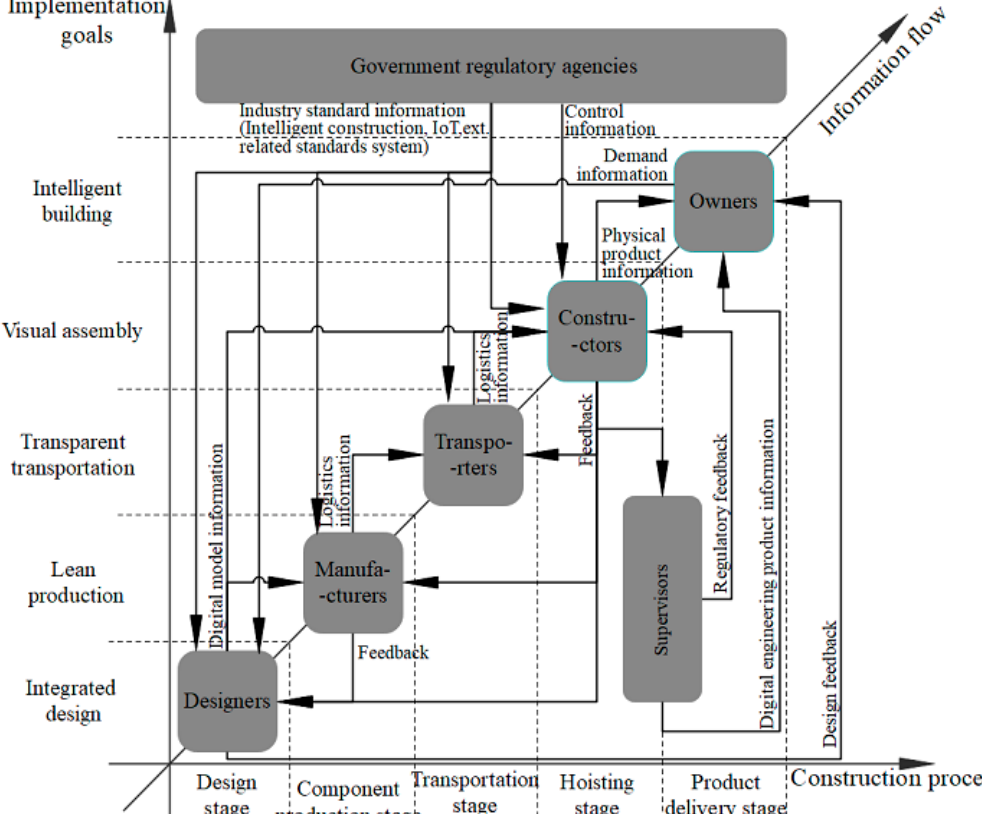
Figure 2. The formation of the ICSPB-IoT “information network”.